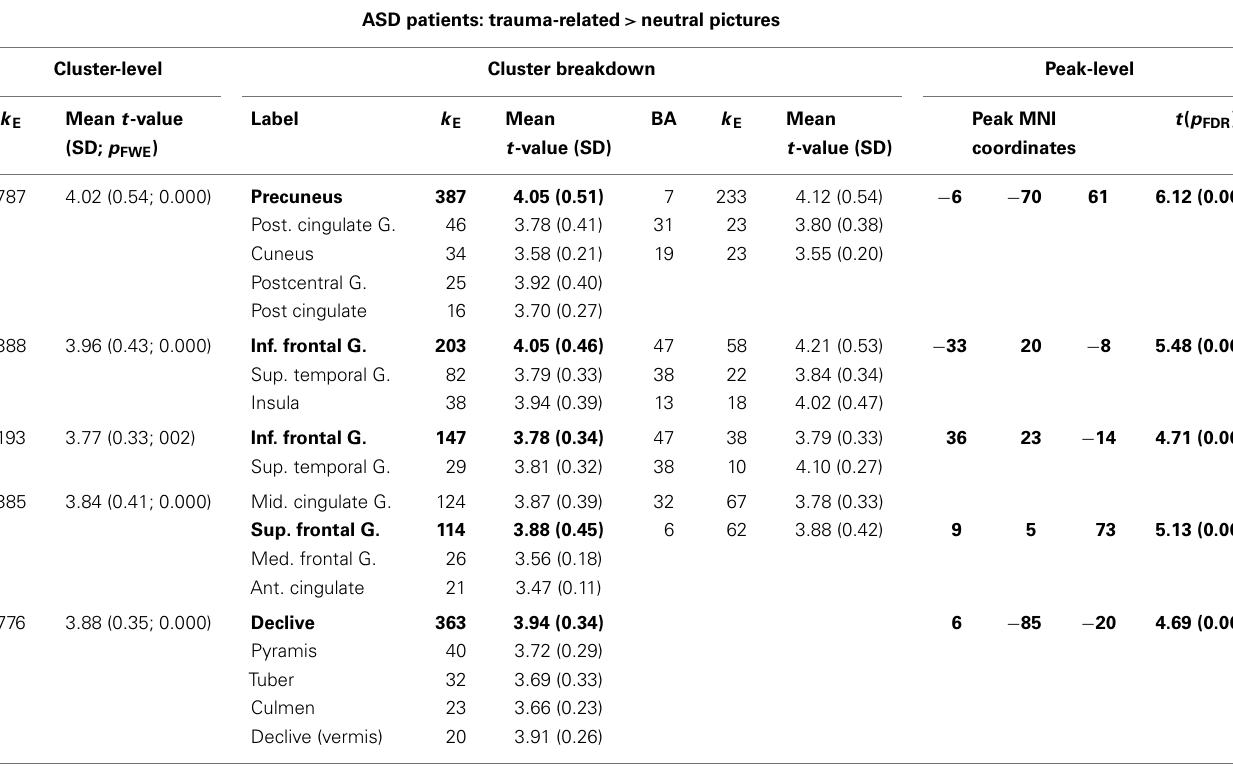
Table 3 |ASD patients: comparison of neural activation to trauma-related as compared to neutral pictures . ASD patients: trauma-related > neutral pictures